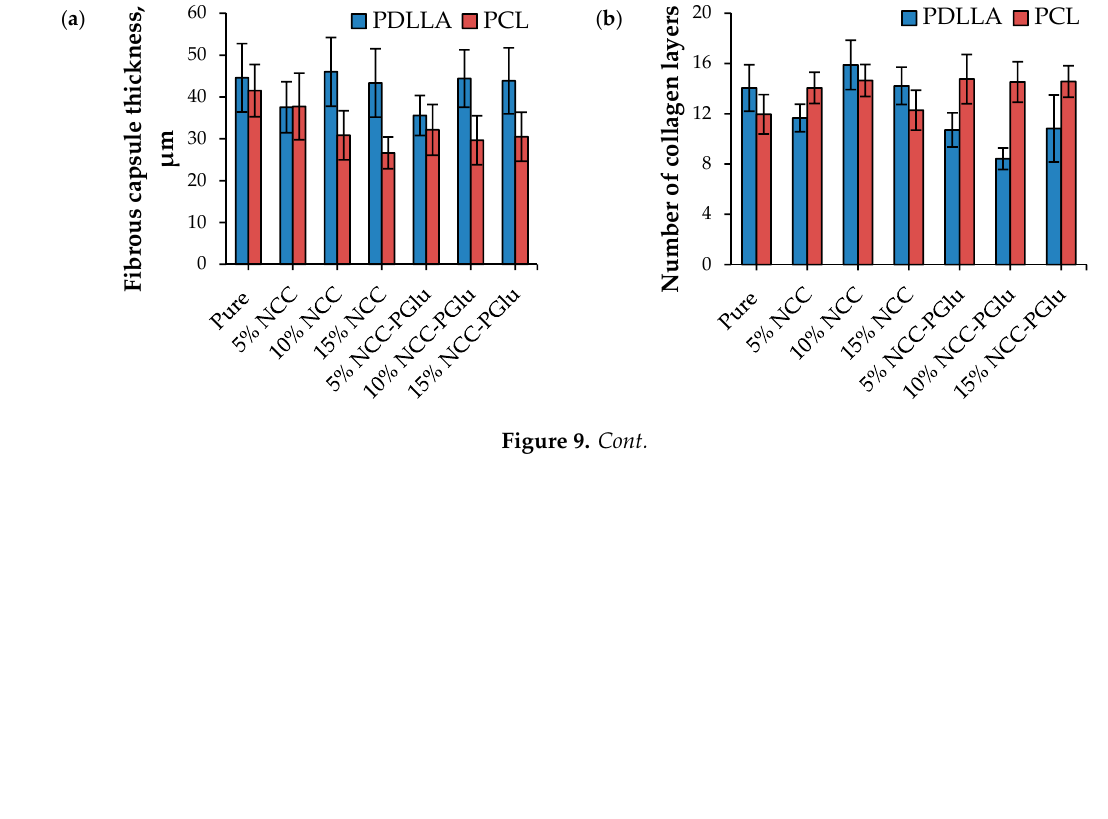
Figure 8. Representative histological sections ( × 40) after four weeks of subcutaneous implantation. (Abbreviations: mph – macrophage, fb – fibroblast, ft – fibrous tissue.).